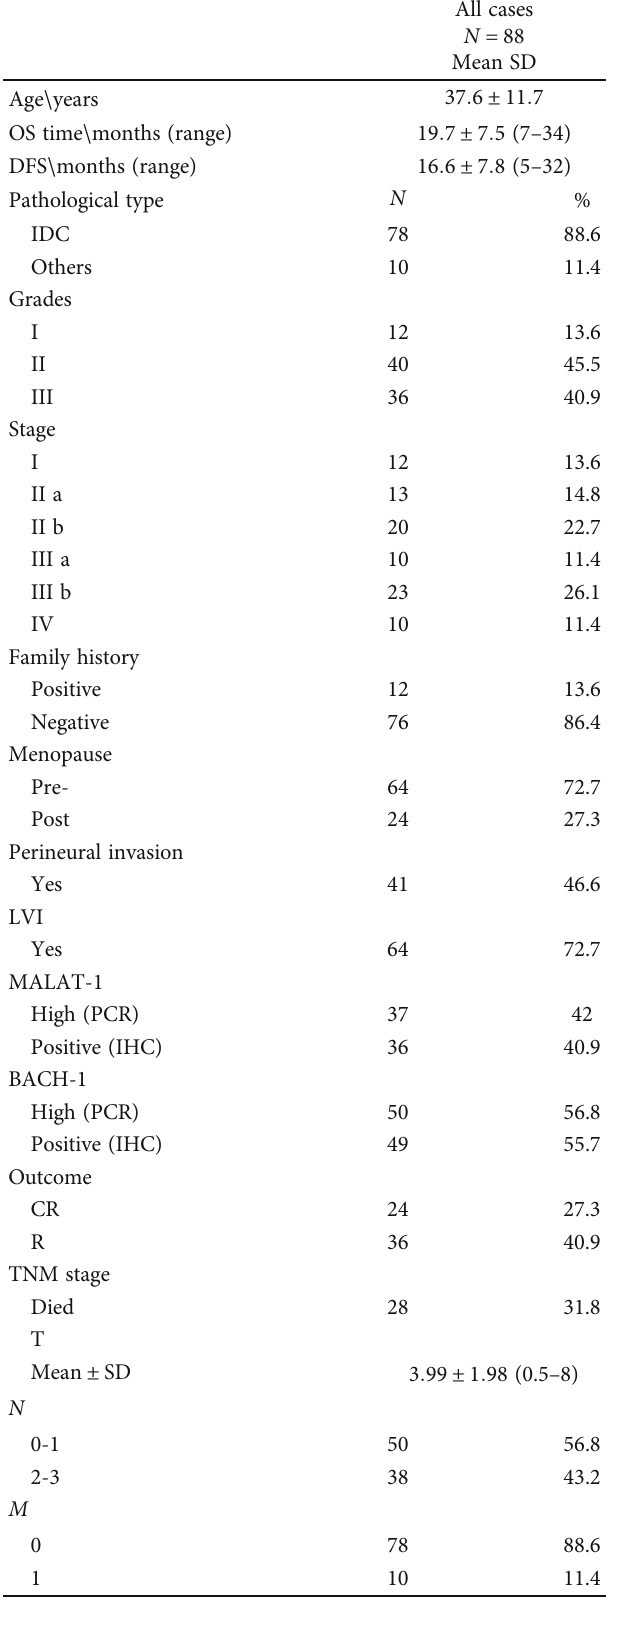
Table 2: The clinicopathologic characteristics of the studied TNBC